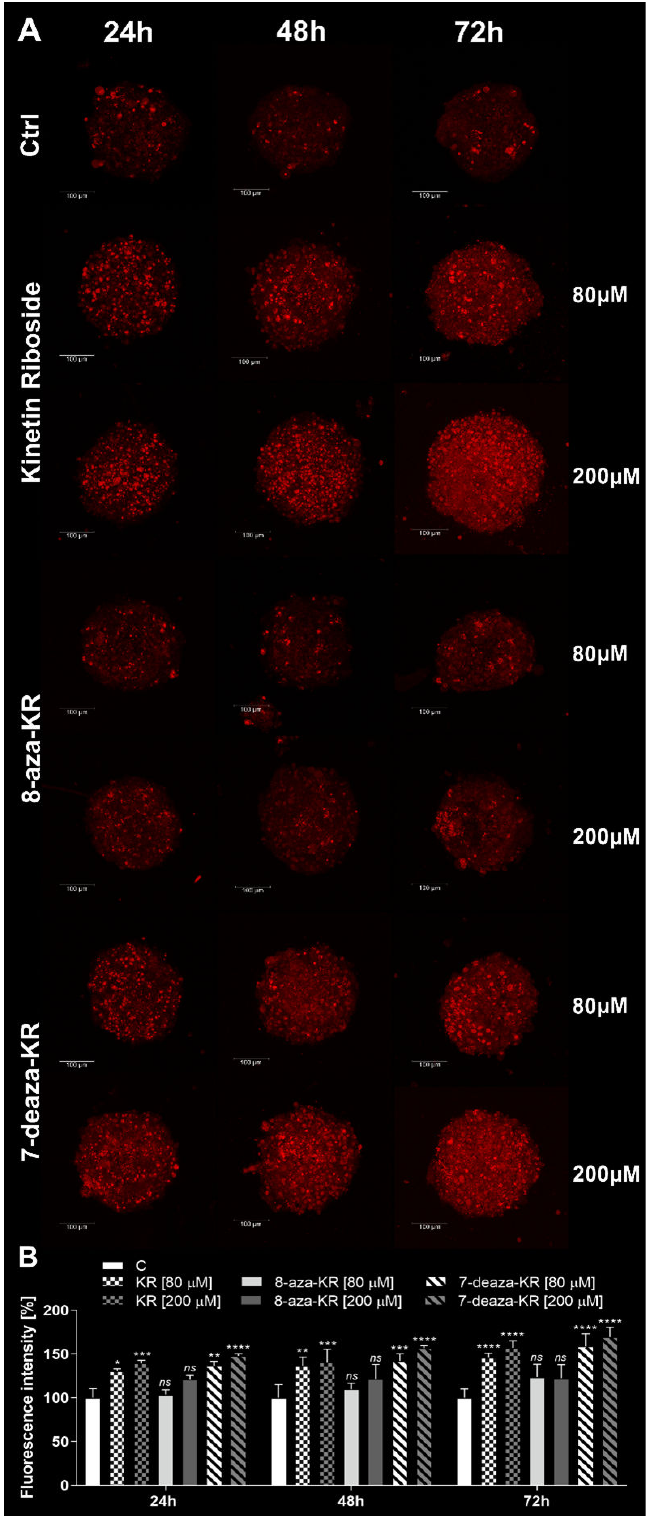
Figure 5. Mitochondrial oxidative stress analysis in T98G spheroids. ( A ) Confocal microscopy analysis of the mitochondrial oxidative stress after 24, 48, and 72 h of treatment with KR, 8-azaKR, and 7-deazaKR (80 and 200 µ M) determined by MitoSOX staining (ex/em: 510/570–600 nm). ( B ) Analysis of changes in the fluorescence intensity of spheroids. The results are presented as the mean fluorescence intensity ± SD of three independent experiments. Statistical significance (two-way ANOVA): (ns) not significant, * p < 0.05, ** p < 0.01, *** p < 0.001, **** p <